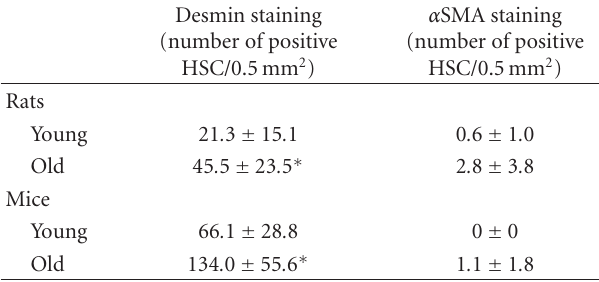
Table 2: Results of immunohistochemical study of the e ff ects of old age on